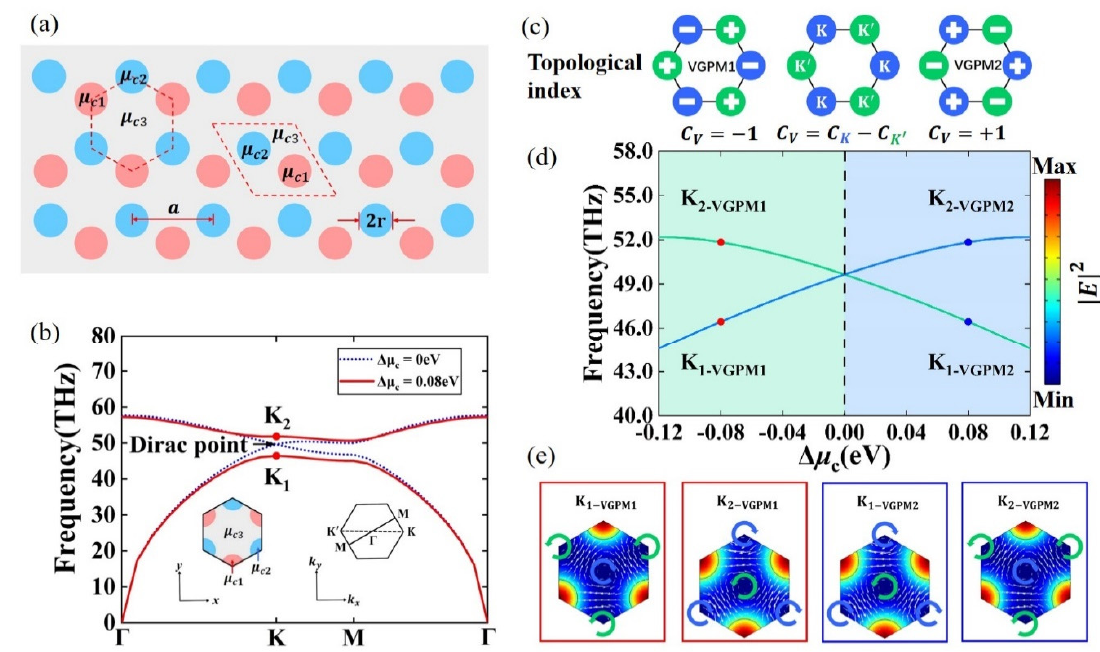
Figure 2. Band structure and valley Hall phase transition in VGPMs. ( a ) Schematic of VGPMs contains two types of unit cells (regular hexagon and rhombus), both of which are composed of two non-equivalent graphene nanodisks (scatterers) and ambient graphene (matrix). The chemical potentials of two graphene nanodisks and ambient graphene are µ c 1 , µ c 2 , and µ c 3 , respectively. The graphene nanodisks radii both are r = 0.21 a , where a is the lattice constant. ( b ) Bulk band for VGPMs with ∆ µ c = µ c 1 − µ c 2 = 0 eV and ∆ µ c = 0.08 eV, respectively. Insets: hexagon unit cell (left) and the first Brillouin zone (BZ) (right). ( c ) Diagram of topological index distributions and theoretical valley Chern numbers for VGPM1 ( ∆ µ c < 0 eV) and VGPM2 ( ∆ µ c > 0 eV). ( d ) Phase diagram revealed by band-edge frequencies at the K 1 and K 2 valleys. Blue and green curves indicate the phase vortex corresponding to clockwise and anticlockwise power flows, respectively. Red/blue dots: frequencies for the designed VGPM1/VGPM2 at the K 1 /K 2 valleys. ( e ) Photonic light fields and power flux field profiles at the K 1 and K 2 valleys corresponding to the red and blue dots in ( d ). Color: | E | 2 ; white arrows: power flux. Blue/green arc arrows represent typical vortex features.